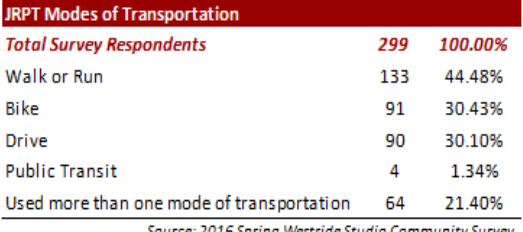
Figure 4. Modes of transportation to access the JRPT. source: created by authors for this paper.